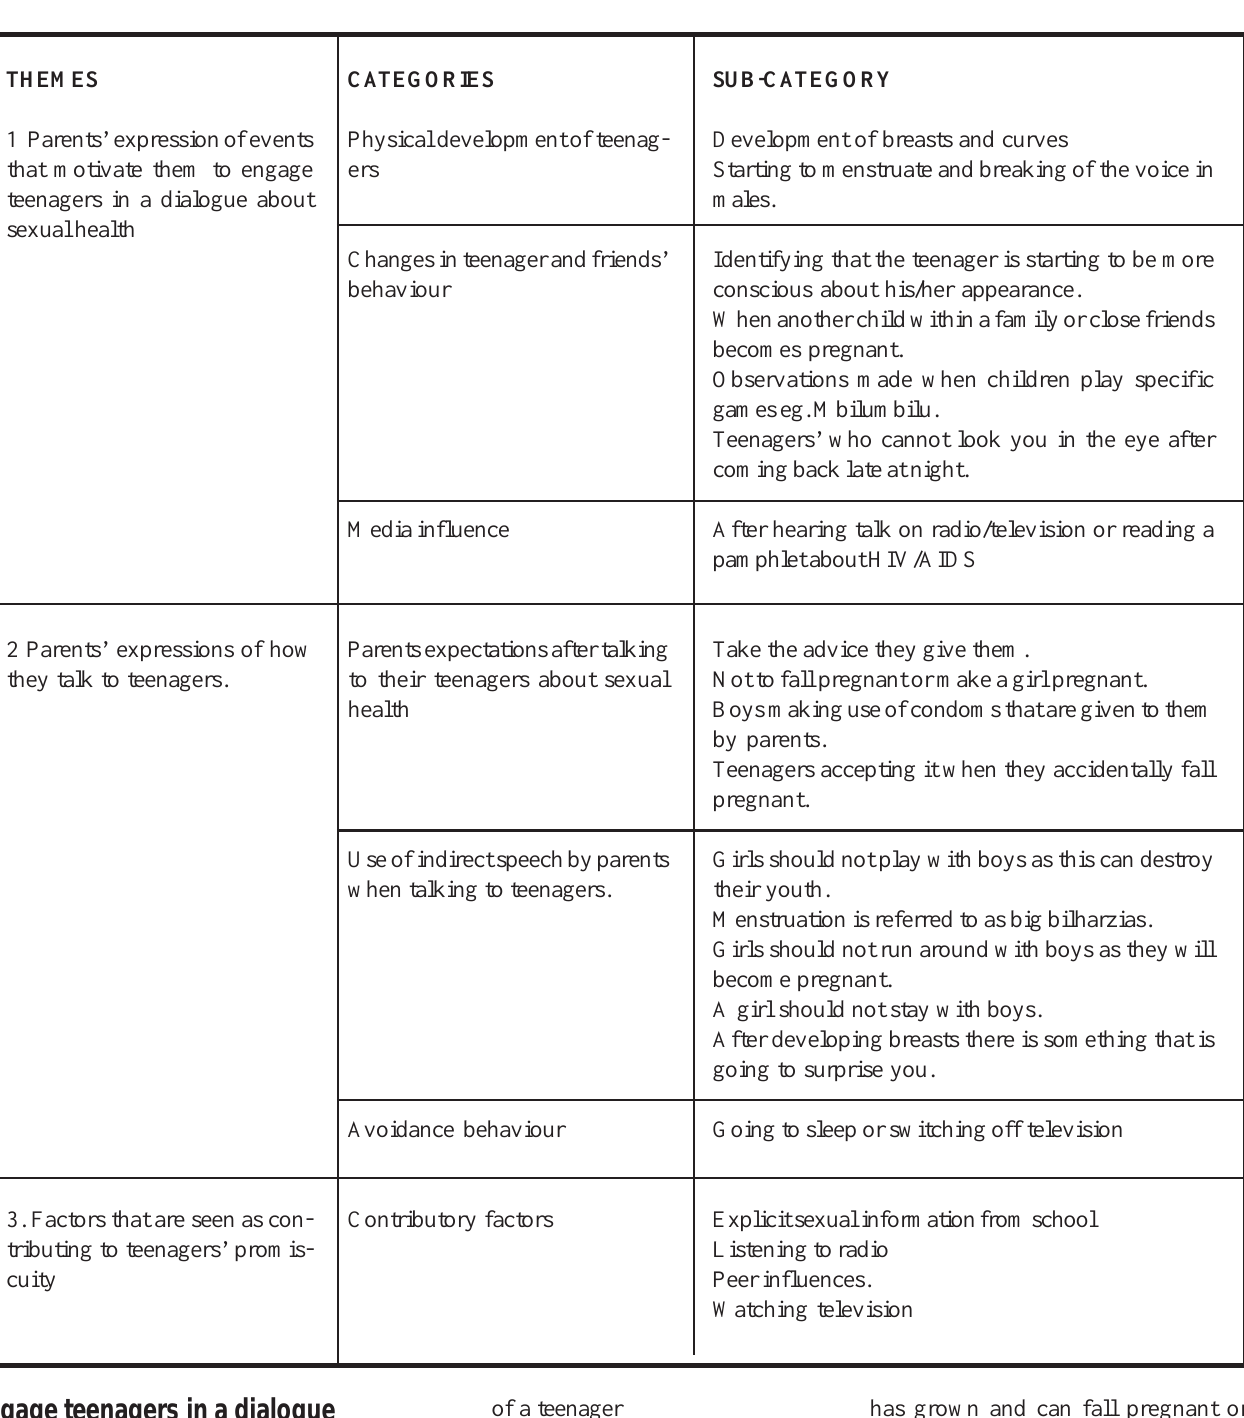
Table 1. Parents’ themes, categories and sub –